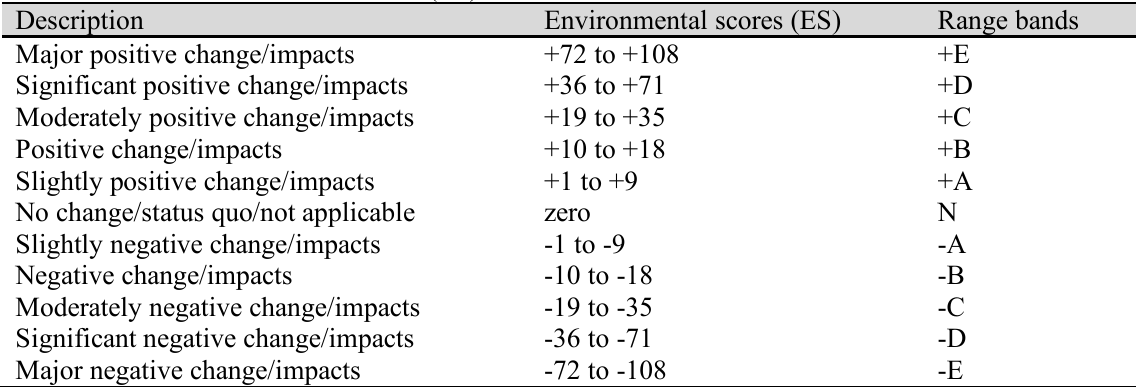
Table 2. RIAM Environmental scores (ES)